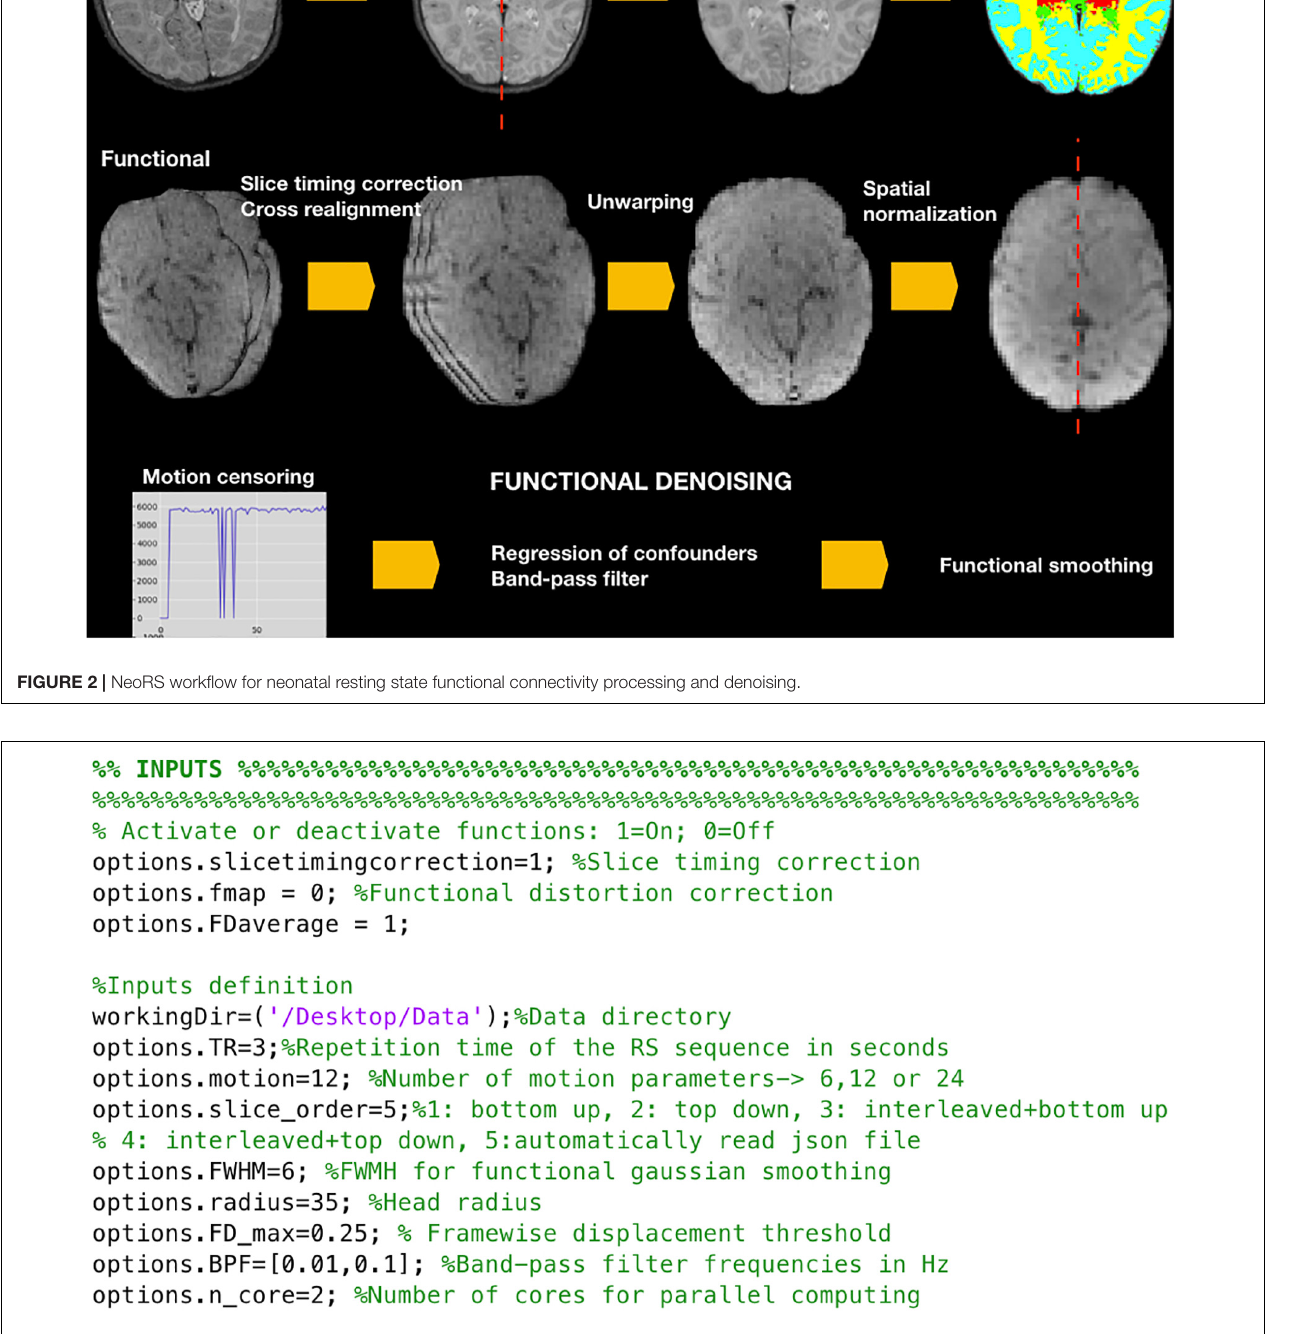
FIGURE 3 | Example of NeoRS input